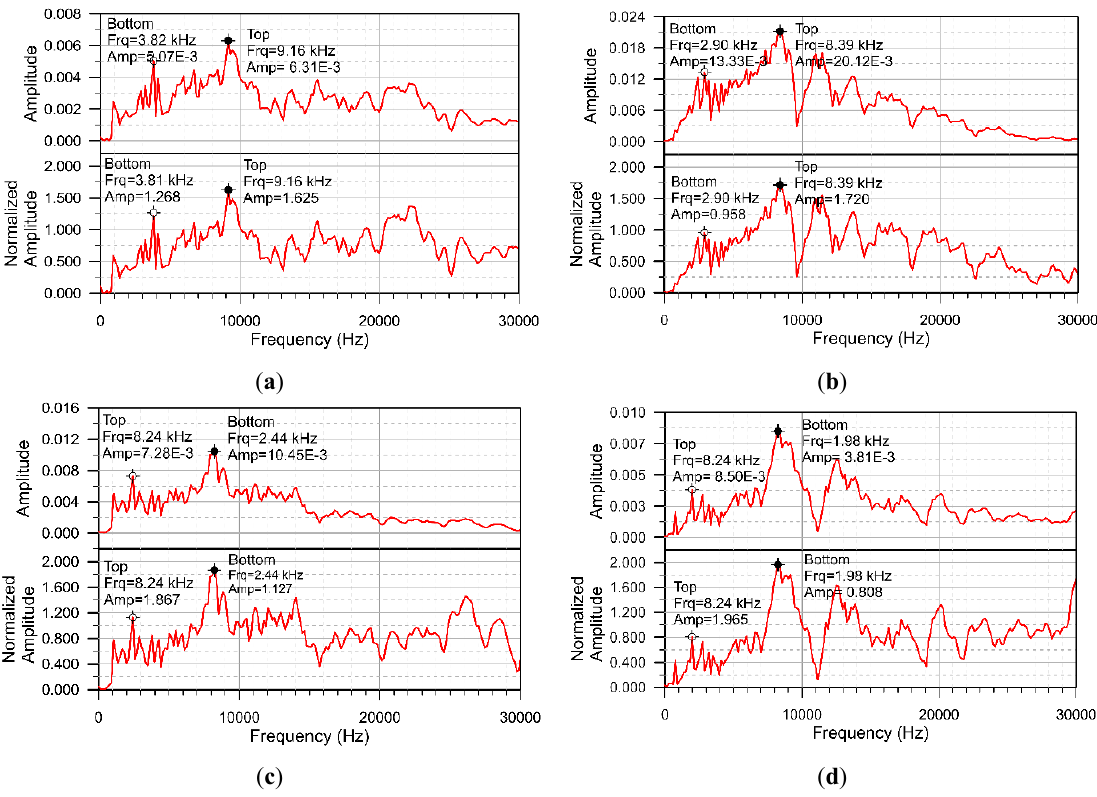
Figure 7. Representative displacement waveform and the normalized amplitude spectra for ( a ) good adhesion; ( b ) A10; ( c ) A20; ( d ) A30.